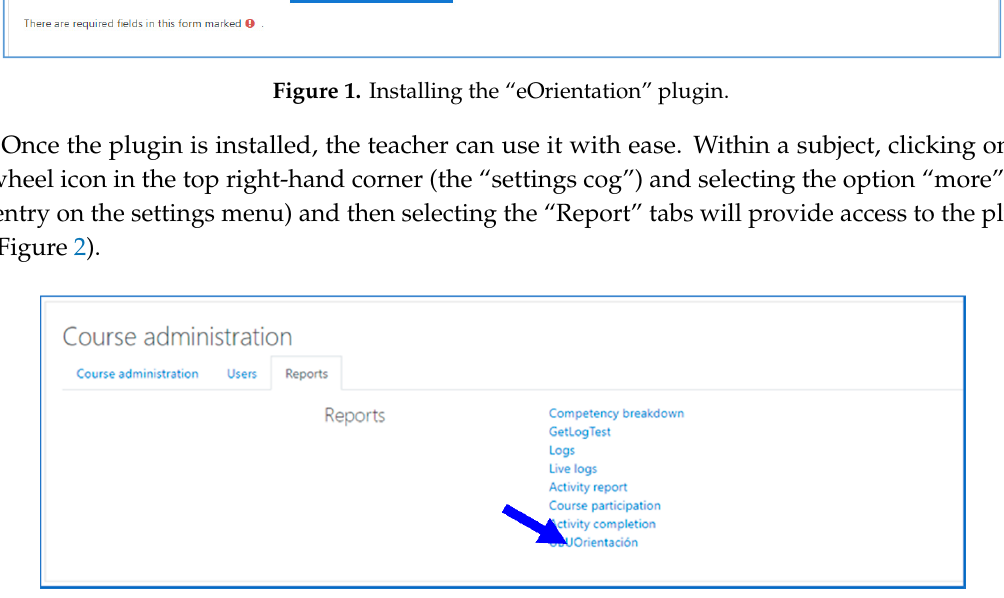
Figure 2. Accessing the “eOrientation” plugin.